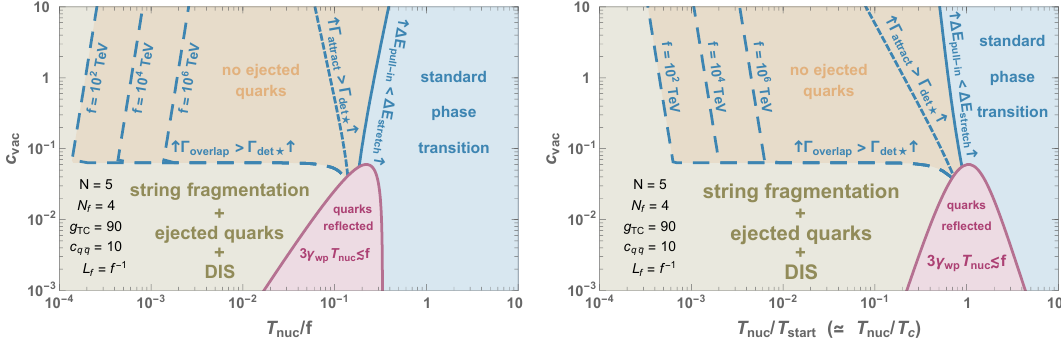
Figure 6 . Blue Region: the incoming techniquanta confine with their neighbours as in the standard picture of phase transitions that are not supercooled. Olive Region: all three inequal- ities, (6.4), (6.7), (6.10), are violated and the new effects pointed out in this study, i.e. string fragmentation, ejection of techniquanta and deep inelastic scattering, should be taken into account. Orange Region: at least one but not all of the inequalities above hold, therefore there are no ejected techniquanta. The dynamics taking place in this region remains to be investigated. Purple Region: quarks are too weakly energetic to enter the bubbles, see. 5.3. Left of solid line: eq. (6.10) is violated and it is energetically favourable for the flux lines to be distorted. Left of dotted line: eq. (6.7) is violated we can neglect the attractive interactions between neighboring flux lines. Left of dashed lines: eq. (6.4) is violated and we can neglect the overlap of neighbouring flux lines. The two plots only differ through their horizontal axis, see section 3.2 for the definitions of c